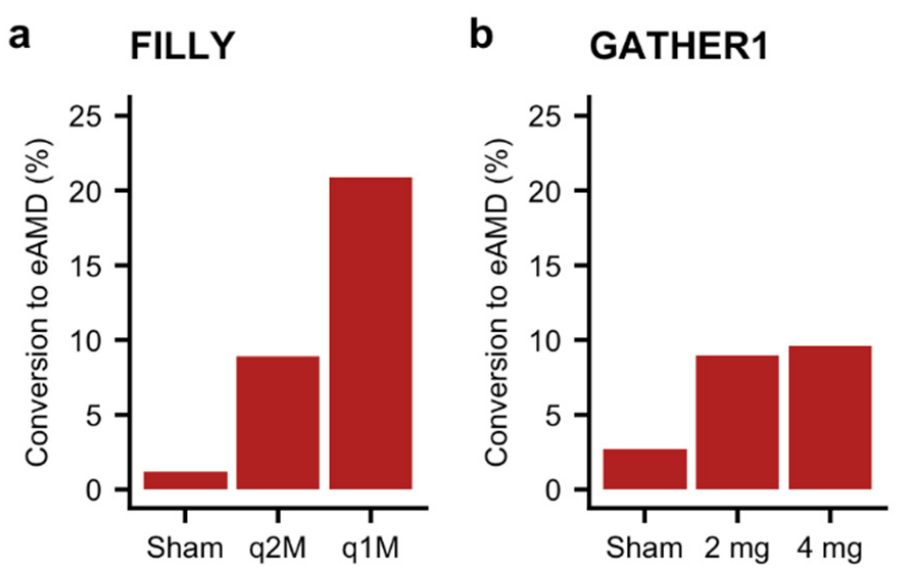
Figure 3. Increased conversion to exudative AMD with complement inhibition. Rates of conversion to exudative age-related macular degeneration (eAMD) in the sham and treatment arms of the ( a ) FILLY [27] and ( b ) GATHER1 [28] studies. q2M/q1M: treatment every 2 months or 1 month.